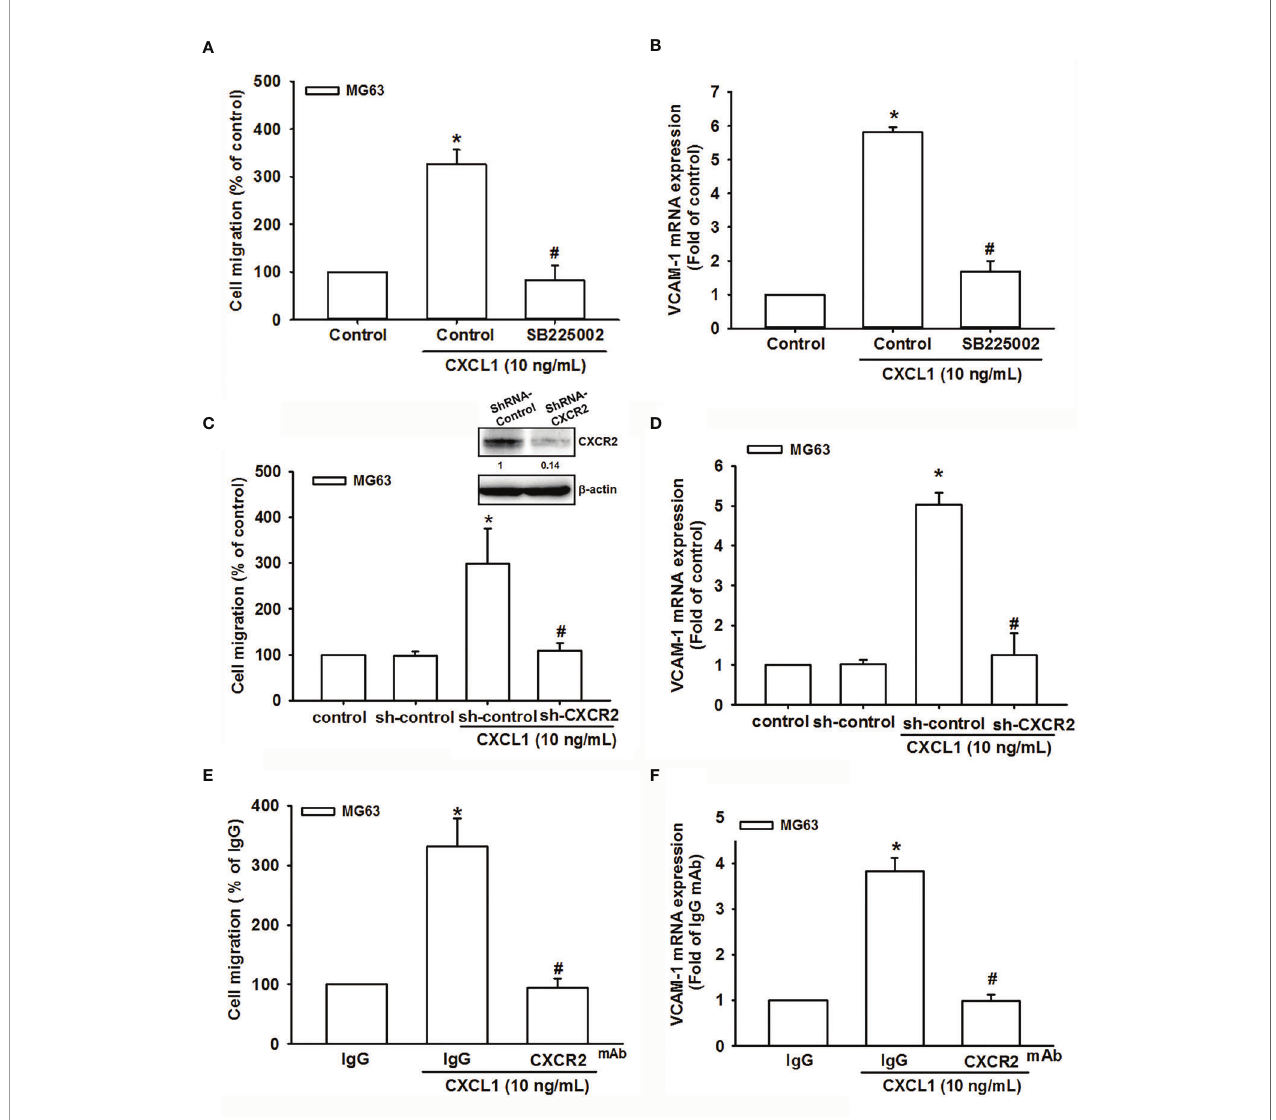
FIGURE 3 | The role of the CXCR2 receptor in CXCL1-mediated cell migration and VCAM-1 expression. (A, B) The CXCR2 antagonist, SB225002. (C, D) CXCR2- shRNA transfection. (E, F) CXCR2 neutralizing antibody reduced CXCL1-induced cell migration and VCAM-1 expression in MG63 cells. The data were collected from at least three individual experiments and expressed as mean ± S.D. * p < 0.05 as compared to the control group; # p < 0.05 compared with the CXCL1-treated shRNA-control and IgG